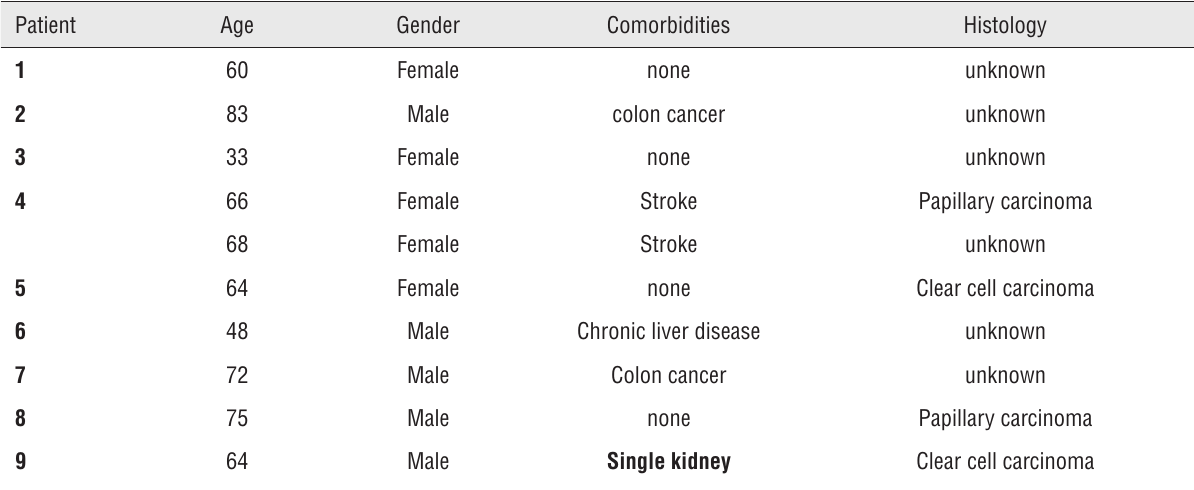
Table 1 - patient’s age and comorbidities submitted to radiofrequency ablation. Patient Age